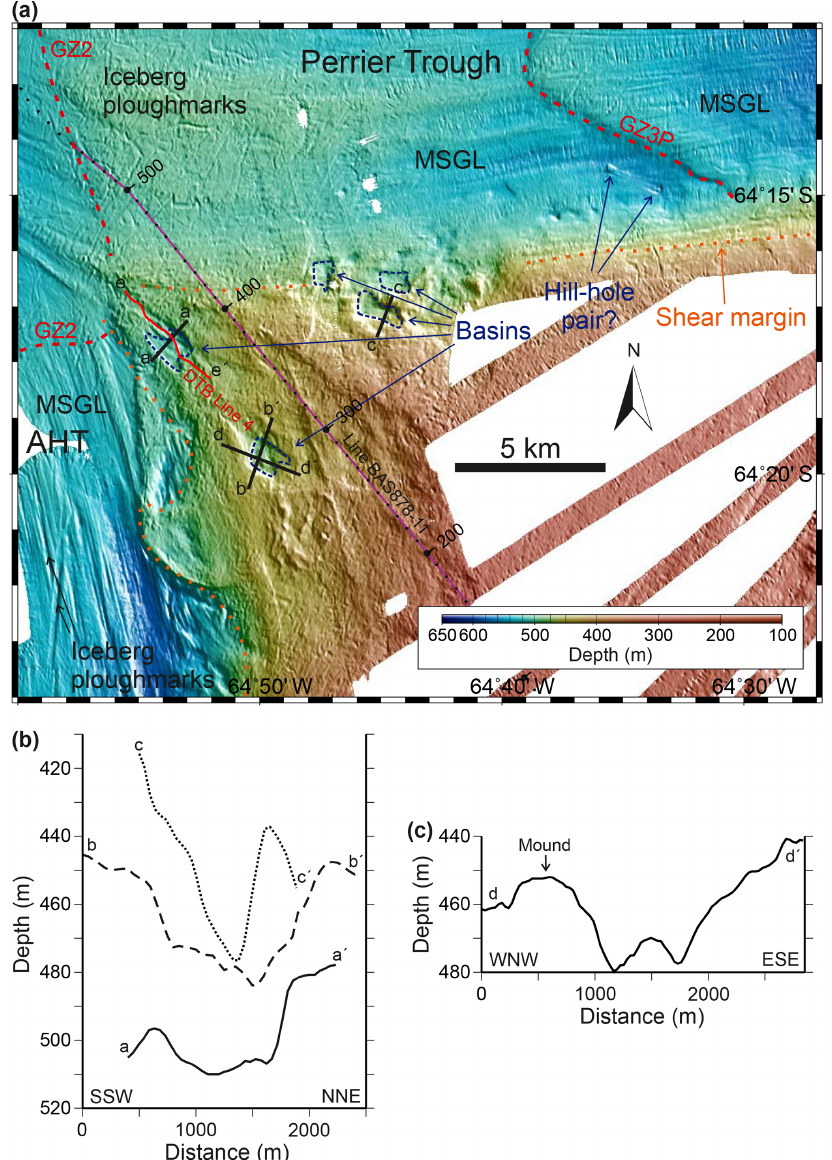
Figure 5. (a) Details of multibeam bathymetry over the confluence between Anvers-Hugo Trough and Perrier Trough, which joins it from the east. Grid-cell size 30m, displayed with shaded relief illumination from northeast. The black lines mark locations of topographic profiles in (b) – (c) . The red line marks the location of the DTB profile in Fig. 6. The purple line marks the location of the MCS profile in Fig. 7, with small dots at intervals of 10 shots and larger dots and annotations at 100-shot intervals. Dark blue dashed lines outline selected box- shaped bathymetric basins. AHT, Anvers-Hugo Trough; MSGL, mega-scale glacial lineations; GZ2, GZ3P, interpreted former grounding zone positions marked by dashed red lines. The orange dotted line marks the lateral limit of MSGL, interpreted as the position of palaeo-ice stream shear margins. (b) Cross sections of box-shaped basins running approximately SW–NE (i.e. approximately transverse to the inferred palaeo-ice flow direction). (c) Cross section of one of the larger basins in an approximately NW–SE direction. Locations of profiles shown in (a)